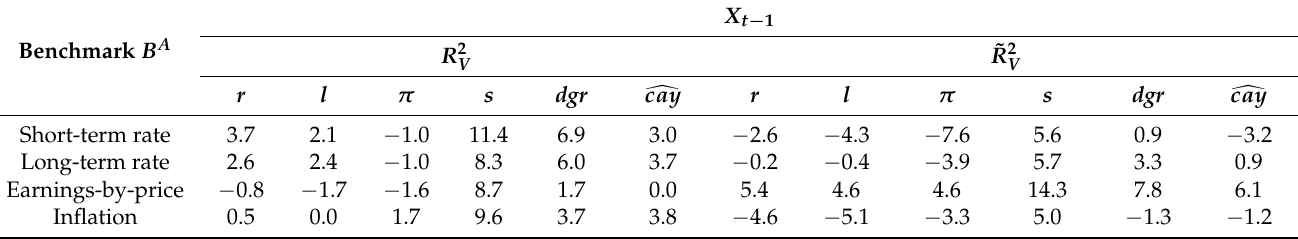
( A ) Table 5. Predictive power for the one-year excess stock returns Y . The prediction problem is defined in (2). The predictive t power (%) is measured by R 2 as defined in (3). The benchmarks B ( A ) considered are based on the short-term interest V rate ( A ≡ R ), long-term interest rate ( A ≡ L ), earnings-by-price ratio ( A ≡ E ), and consumer price index ( A ≡ C ). The predictive variables X t − 1 used are given by the short-term interest rate r t − 1 , long-term interest rate l t − 1 , inflation π t − 1 , term spread s t − 1 , debt-by-GDP ratio dgr t − 1 and consumption–wealth ratio (cid:99) cay . The predictive power (%) for the one-year t − 1 stock returns ln S t validated on the original scale without benchmark is measured by ˜ R 2 as defined in (5) in terms of V back-transformed stock return prediction (cid:100) ln S t defined in (4). The sample period is